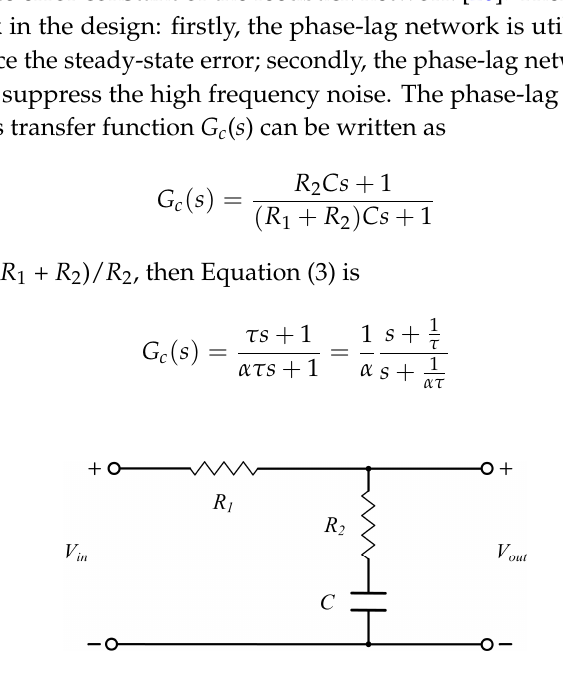
Figure 6. The phase-lag compensation network.